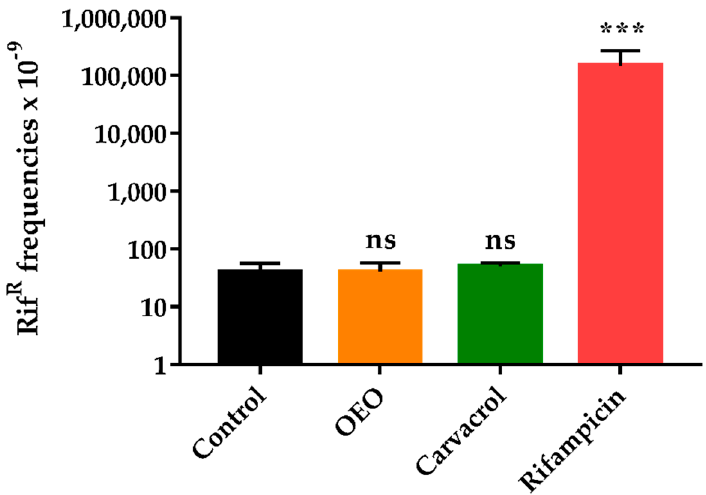
Figure 3. Mutagenesis frequency in S. aureus USA300 grown in broth (control, ■ ) and with orange essential oil (OEO; 750 μ L/L; ■ ), carvacrol (50 μ L/L, ■ ) and rifampicin (0.01 mg/L, ■ ). Mutagenesis frequency was expressed as rifampicin ‐ resistant cells in the total microbial population. Data are means ± standard deviations (error bars) obtained from five independent experiments. ns: no statistically significant differences ( p > 0.05); *** : statistically significant differences ( p ≤ 0.001), in comparison with control.